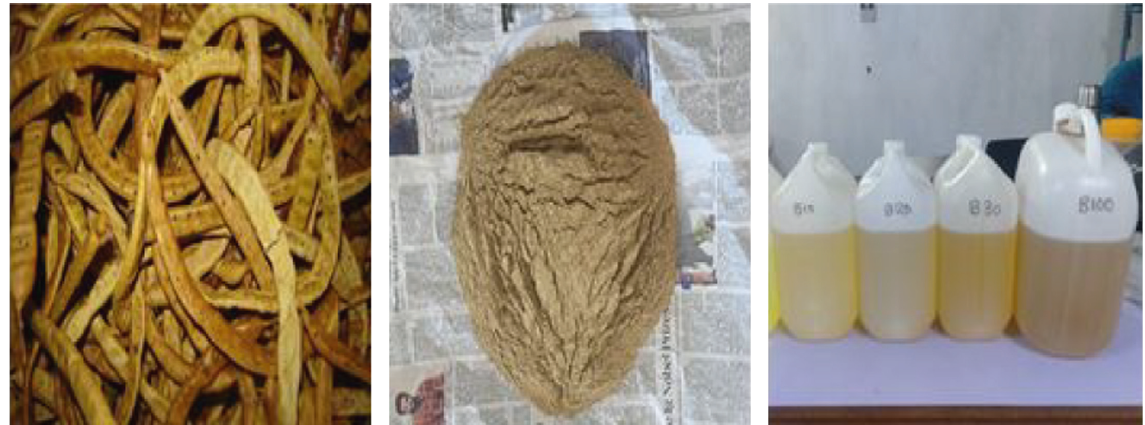
Figure 1: Prosopis juliflora pods, seed powder, and Prosopis juliflora